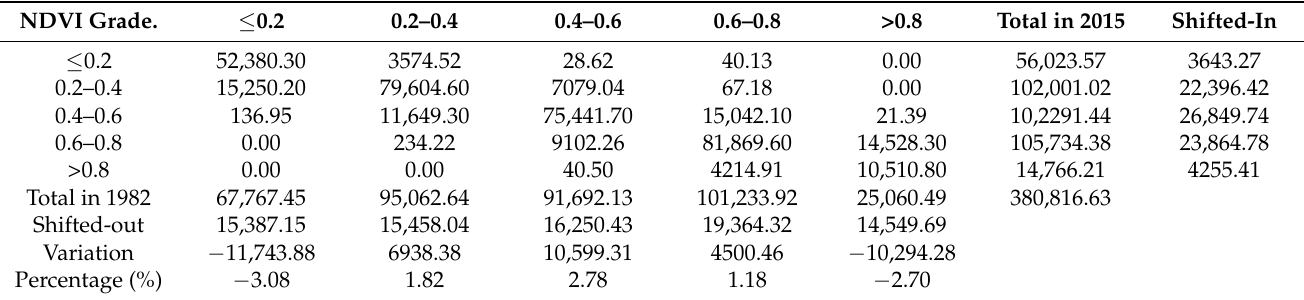
Table 3. The transfer matrix of NDVI changes during 1982–2015 (km 2